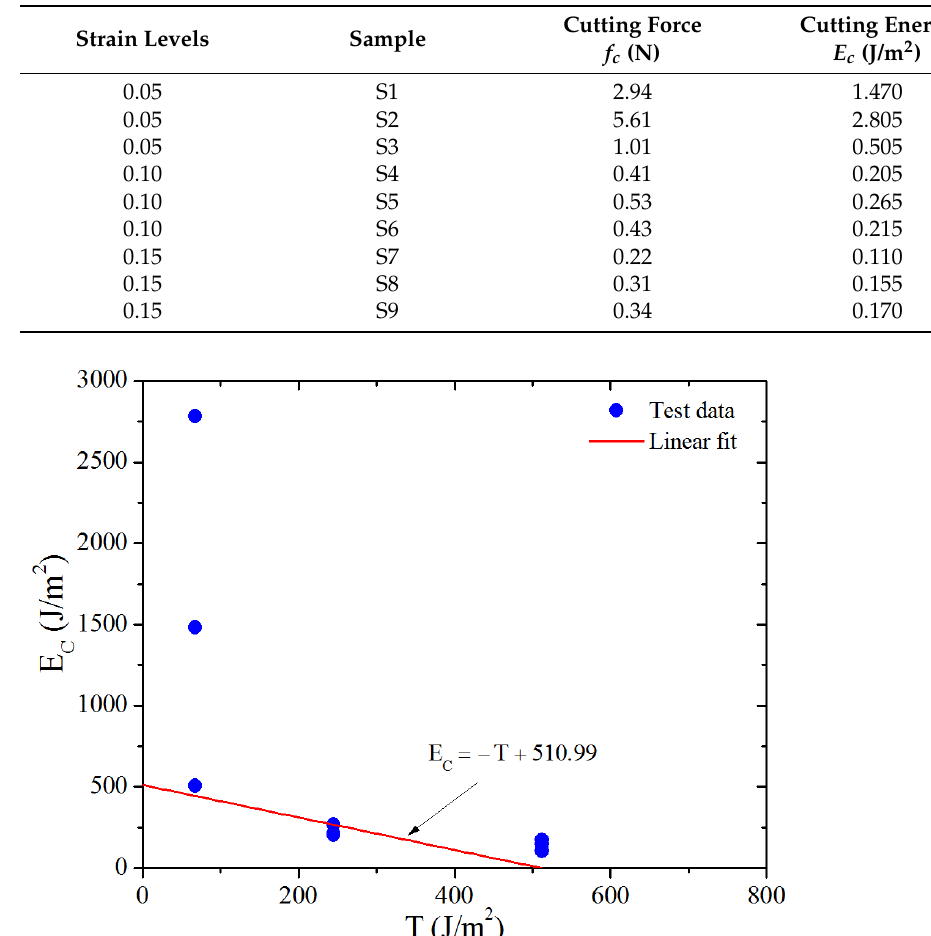
Figure 6. The test and linear fitting results of cutting energy versus tearing energy.